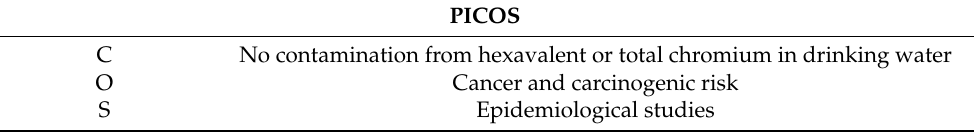
Table 1. Cont. PICOS C No contamination from hexavalent or total chromium in drinking water O Cancer and carcinogenic risk S Epidemiological studies P = Population, I = Intervention, C = Comparator, O = Outcome, S = Study.